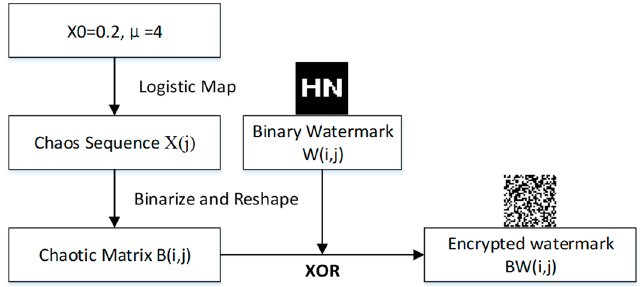
Figure 6. Watermark encryption process.